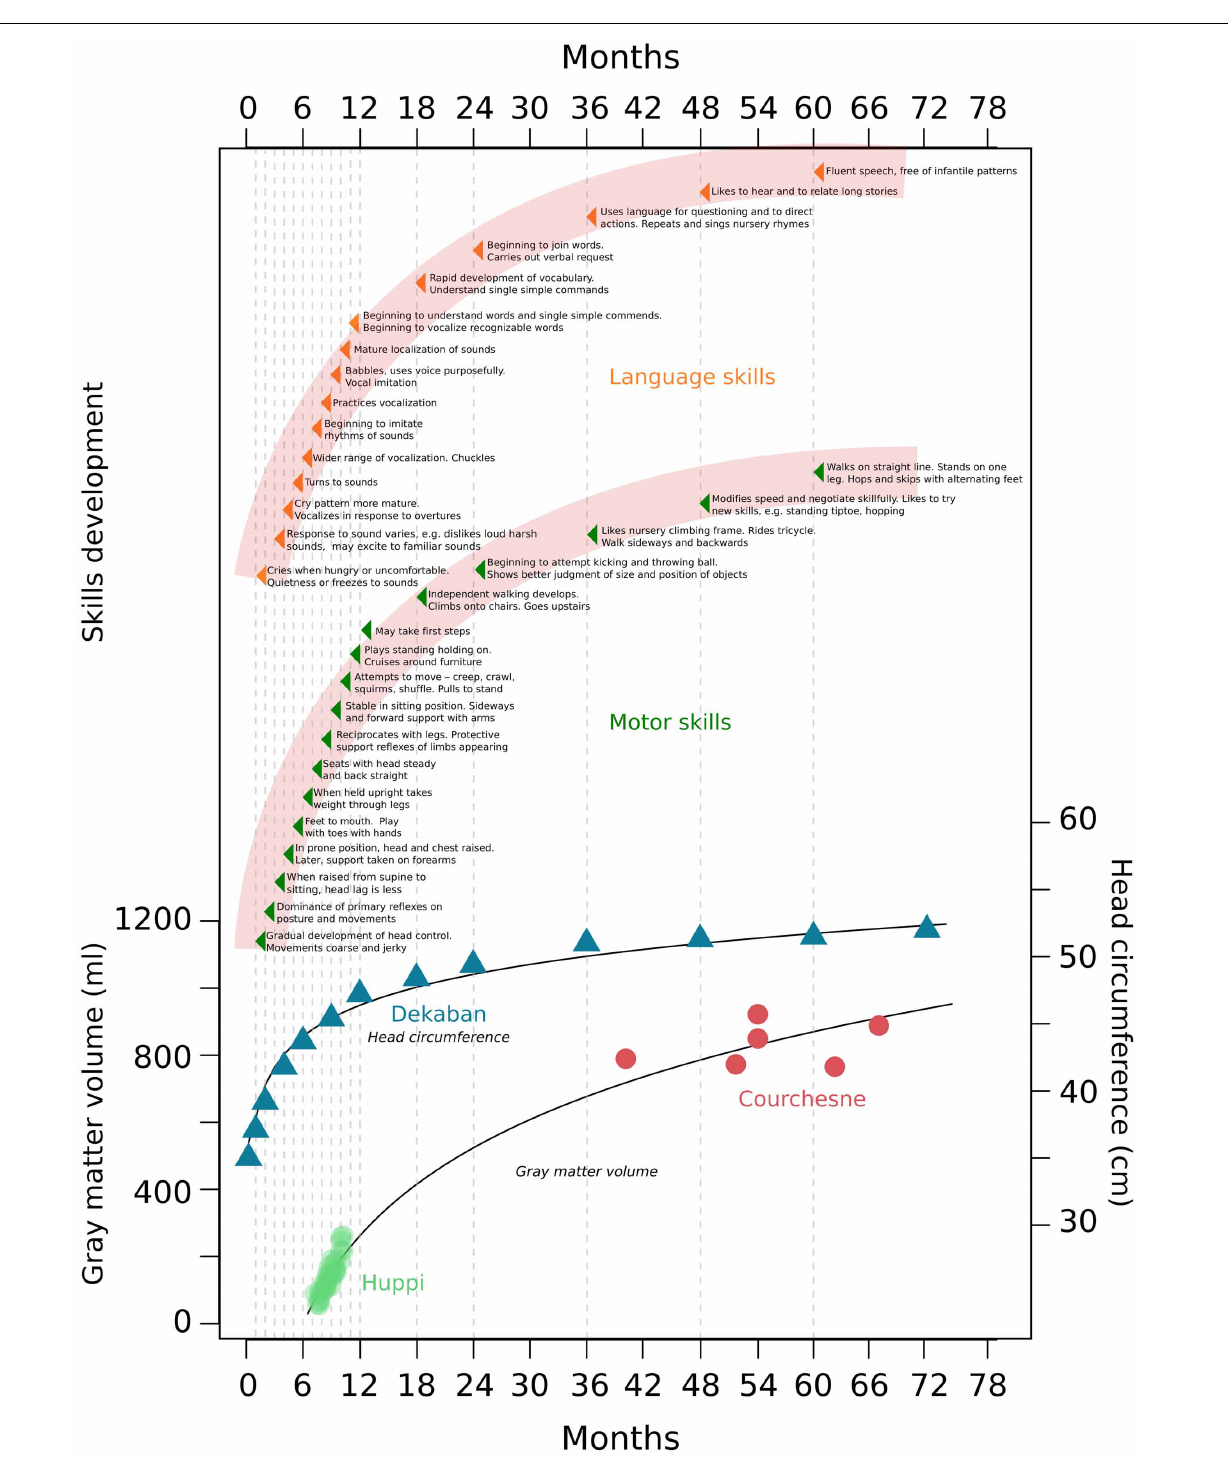
with the normal development of human skills as described in child development text books. Data was taken from Dekaban, 1977; Huppi et al., 1998; Courchesne et al., 2000 and Holt,